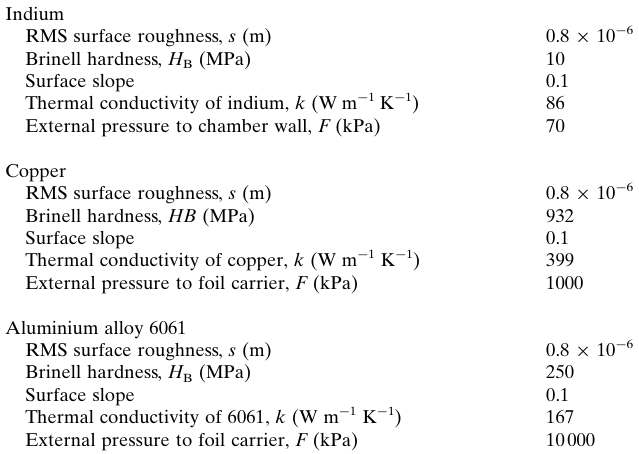
Table 3 Parameters used to compute the micro-contact thermal resistance (Yovanovich,